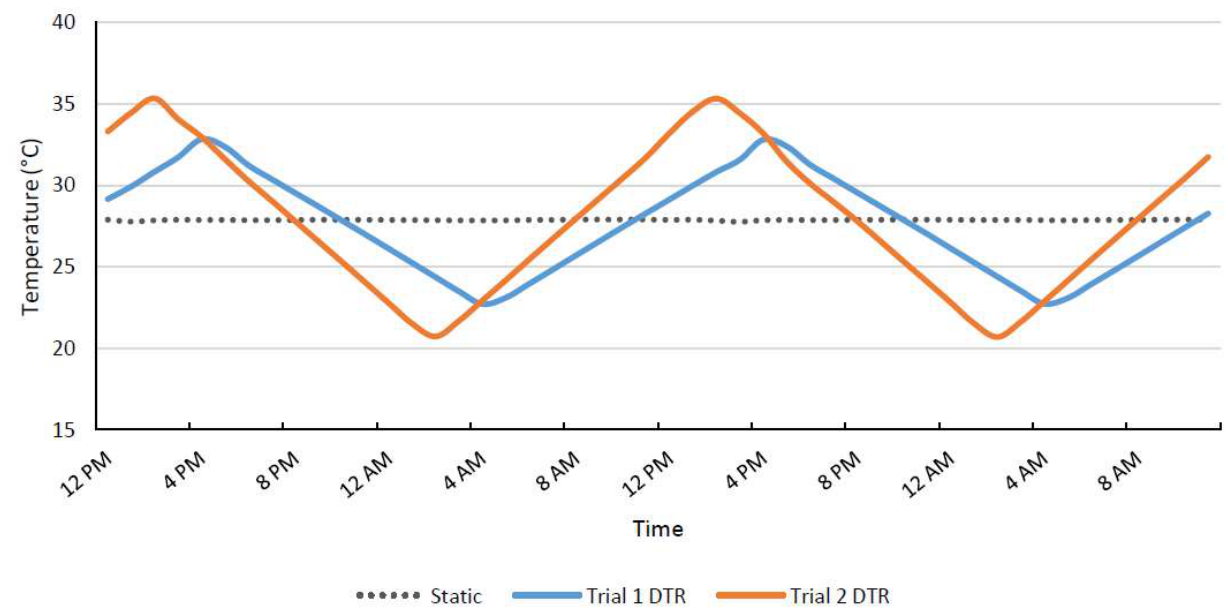
Figure 1. Temperature readouts of Hobo monitors placed inside incubators held at a static temperature of 28 °C, trial 1 11 °C DTR between 22.5 and 33.5 °C, and trial 2 15 °C DTR between 20.5 and 35.5 °C.